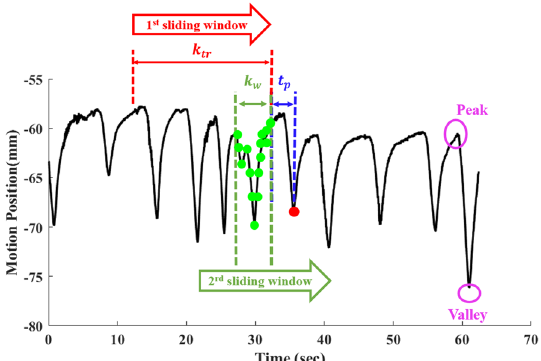
Figure 3. A schematic representation of the algorithm implemented in our photonic RC network for real-time tumor motion prediction. Dual-sliding windows comprising t tr (20 s) and k w (15 data points) are sliding in sync. The maximum look-ahead time studied in this work is t p = 333 ms, which corresponds to h p = 10. Figure shows one prediction example, where the input window data (green dots) are used to predict the data value 333 ms in the future (red